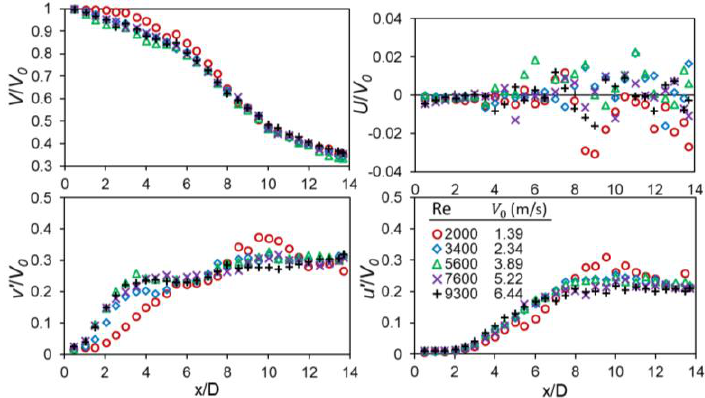
Figure 8. Centerline characteristics of mean and turbulent flow field.